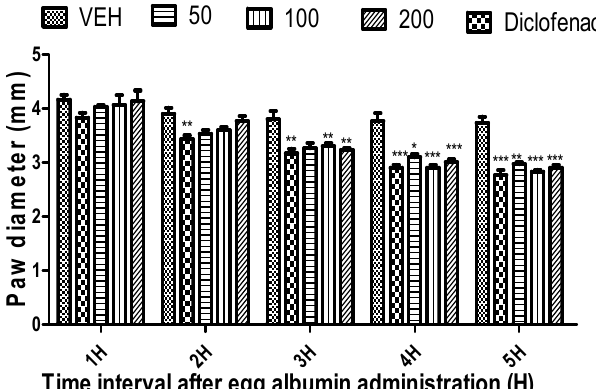
Figure 4. Effect of “Rose Pink” grapefruit ( C. paradisi ) fresh leaves essential oil on egg albumin- induced rat paw oedema. Results are expressed as Mean ± SEM. VEH, ECH and ASA represent vehicle (5% Tween 80), Rose leaves essential oil (FRLG) and diclofenac, respectively. * p < 0.05, ** p < 0.01 and *** p < 0.001, statistically different from negative control group (ANOVA, Dunnett’s).